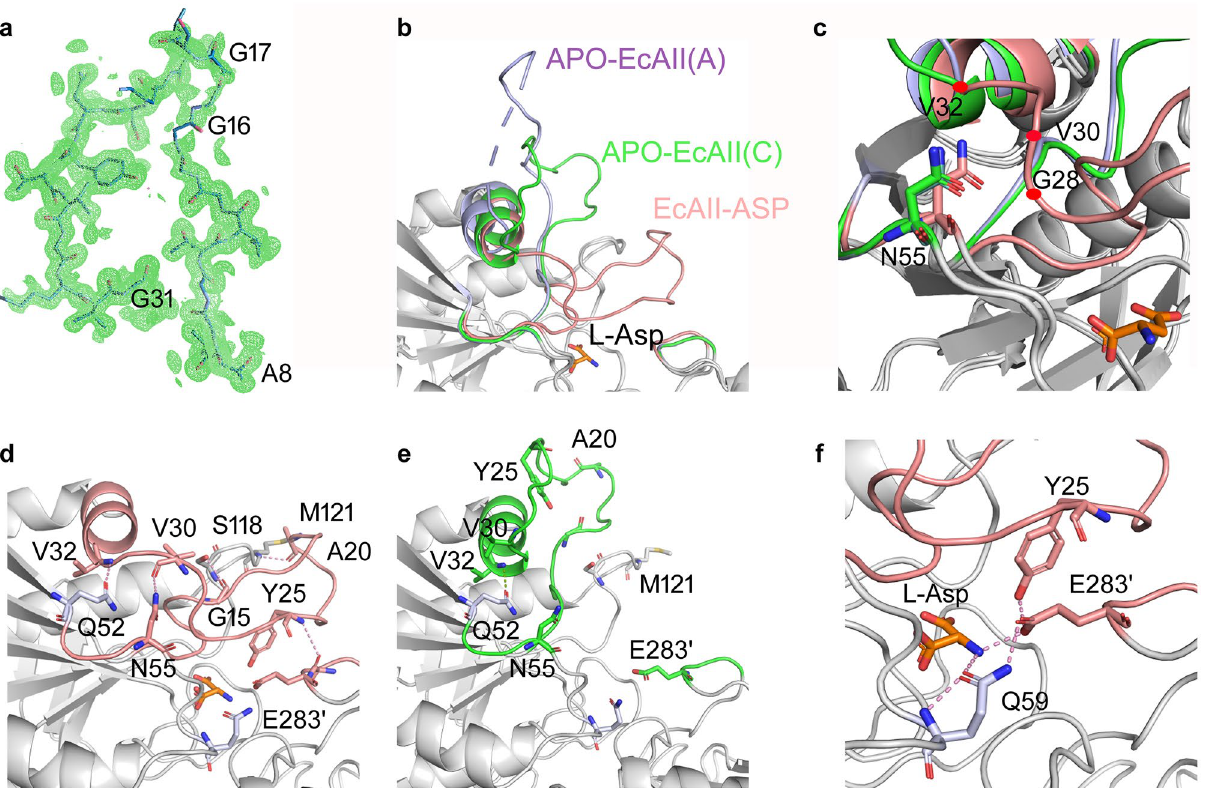
Figure 1. ( a ) Electron density (e.d.) of chain C active site flexible loop (8–31). E.d. (2Fo-Fc map) is shown in green at 0.273 e/Å 3 —7 r.m.s.d., residues as ball and stick. The fragment starting and ending residues are labeled, as well as residues G16 and G17, which showed poor e.d. and were modeled with 0 occupancy. ( b , c ) Superposition of the catalytic region of APO-EcAII protomer A (purple, PDB ID: 6IZY) and C (green) and EcAII-ASP (pink, PDB ID: 1NNS). The l-Asp ligand is represented as sticks. In ( c ) only regions different in the three structures are colored. ( d ) EcAII-ASP flexible loop anchoring points. Residues involved in hydrogen bonds are represented as sticks. ( e ) APO-EcAII (protomer C) flexible loop anchoring points. Residues involved in loop anchoring in the l-Asp-bound structure are represented as sticks for comparison. ( f ) Triangular network between intimate dimer residues relevant for catalysis in the EcAII-ASP